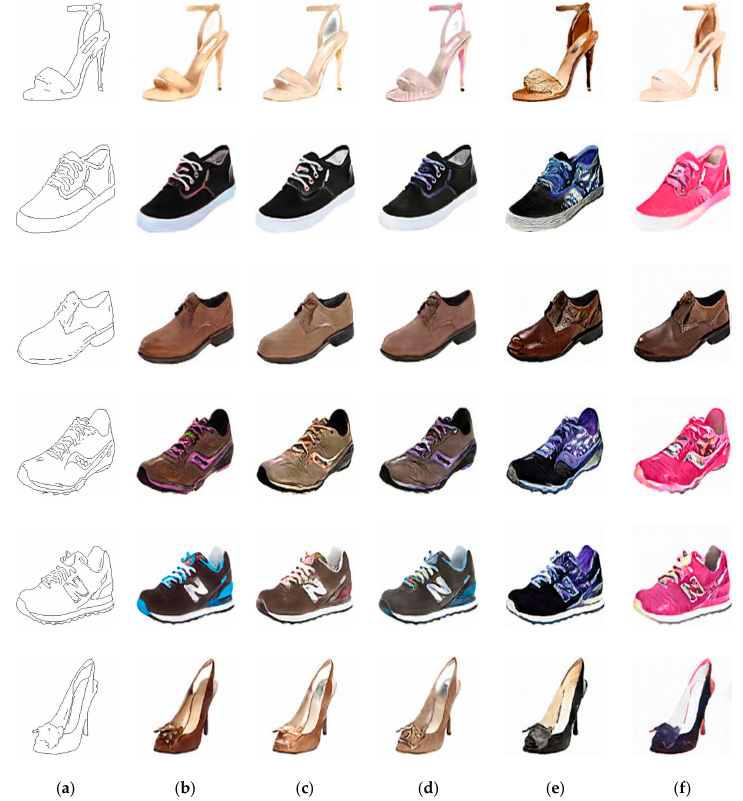
Figure 8. Samples result from edges to shoes. ( a ) input images, ( b ) results of the IP-RAN, ( c ) results of the pix2pix-cGAN, ( d ) results of PAN, ( e ) results of UTN-GAN, and ( f ) results of iPANs